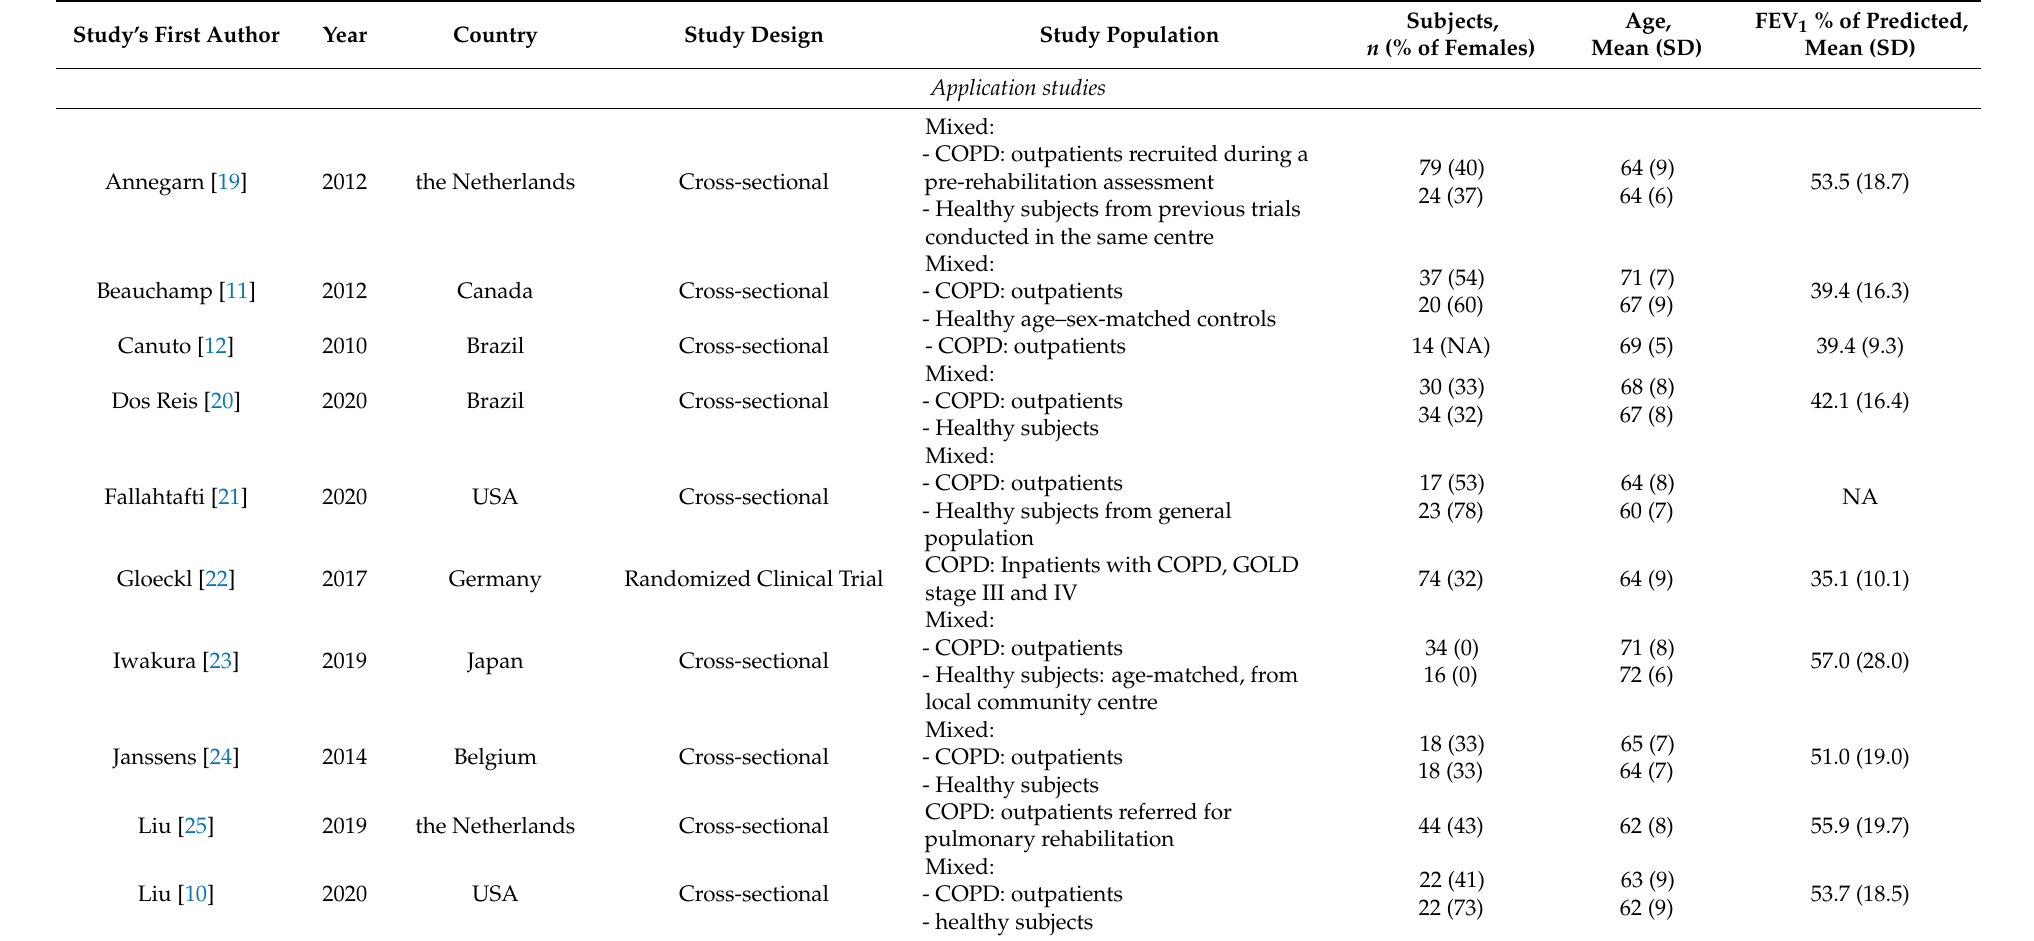
Table 1. Characteristics of the included